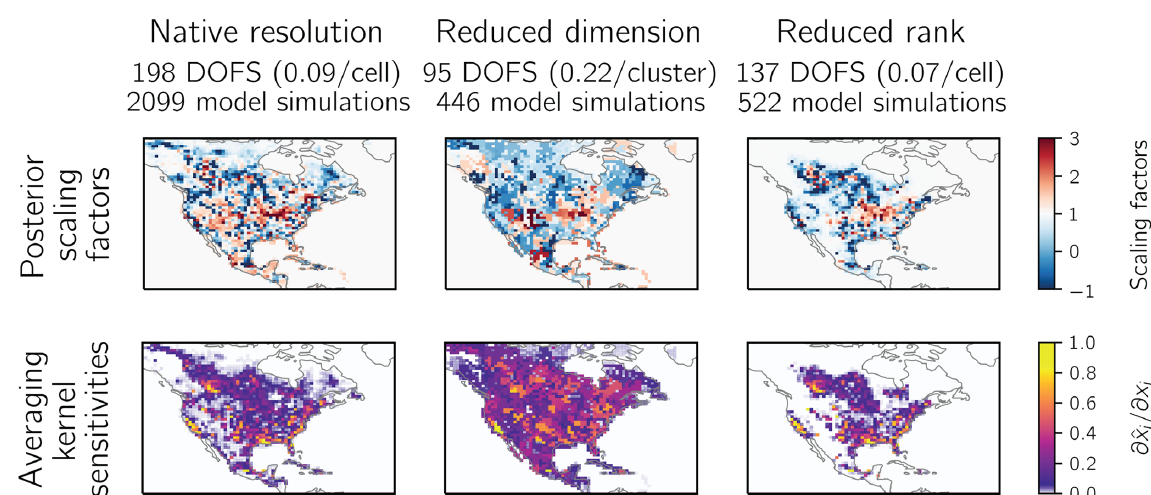
Figure 3. Results from the demonstration inversion at native resolution compared to the reduced-dimension and reduced-rank methods. The figure shows the posterior scaling factors with respect to the prior emissions estimate and the averaging kernel sensitivities for each inversion. The degrees of freedom for signal (DOFS) give the number of pieces of information that the inversion can independently